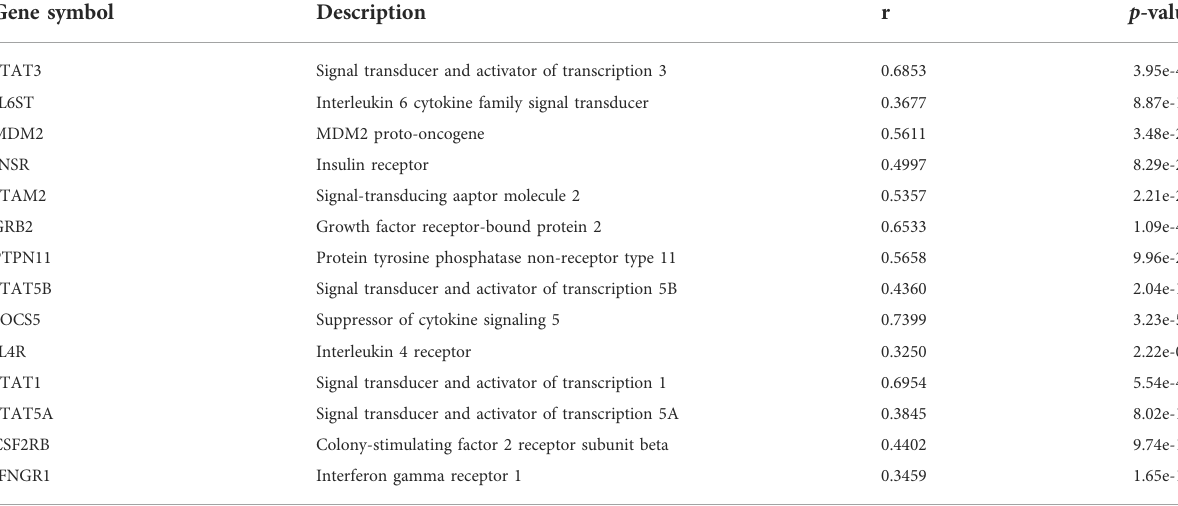
TABLE 1 Gene expression correlation between JAK1 and STRING-reported genes in APL. Gene symbol